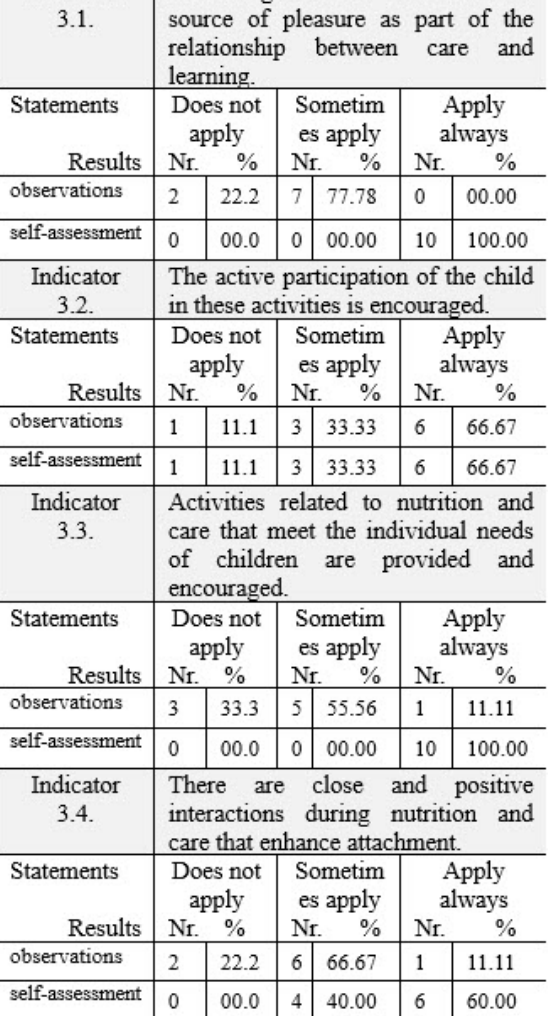
Table 17. Principle 4: Every child is protected from violence, lack of care and in - jury by promoting appropriate practices, pre - vention and